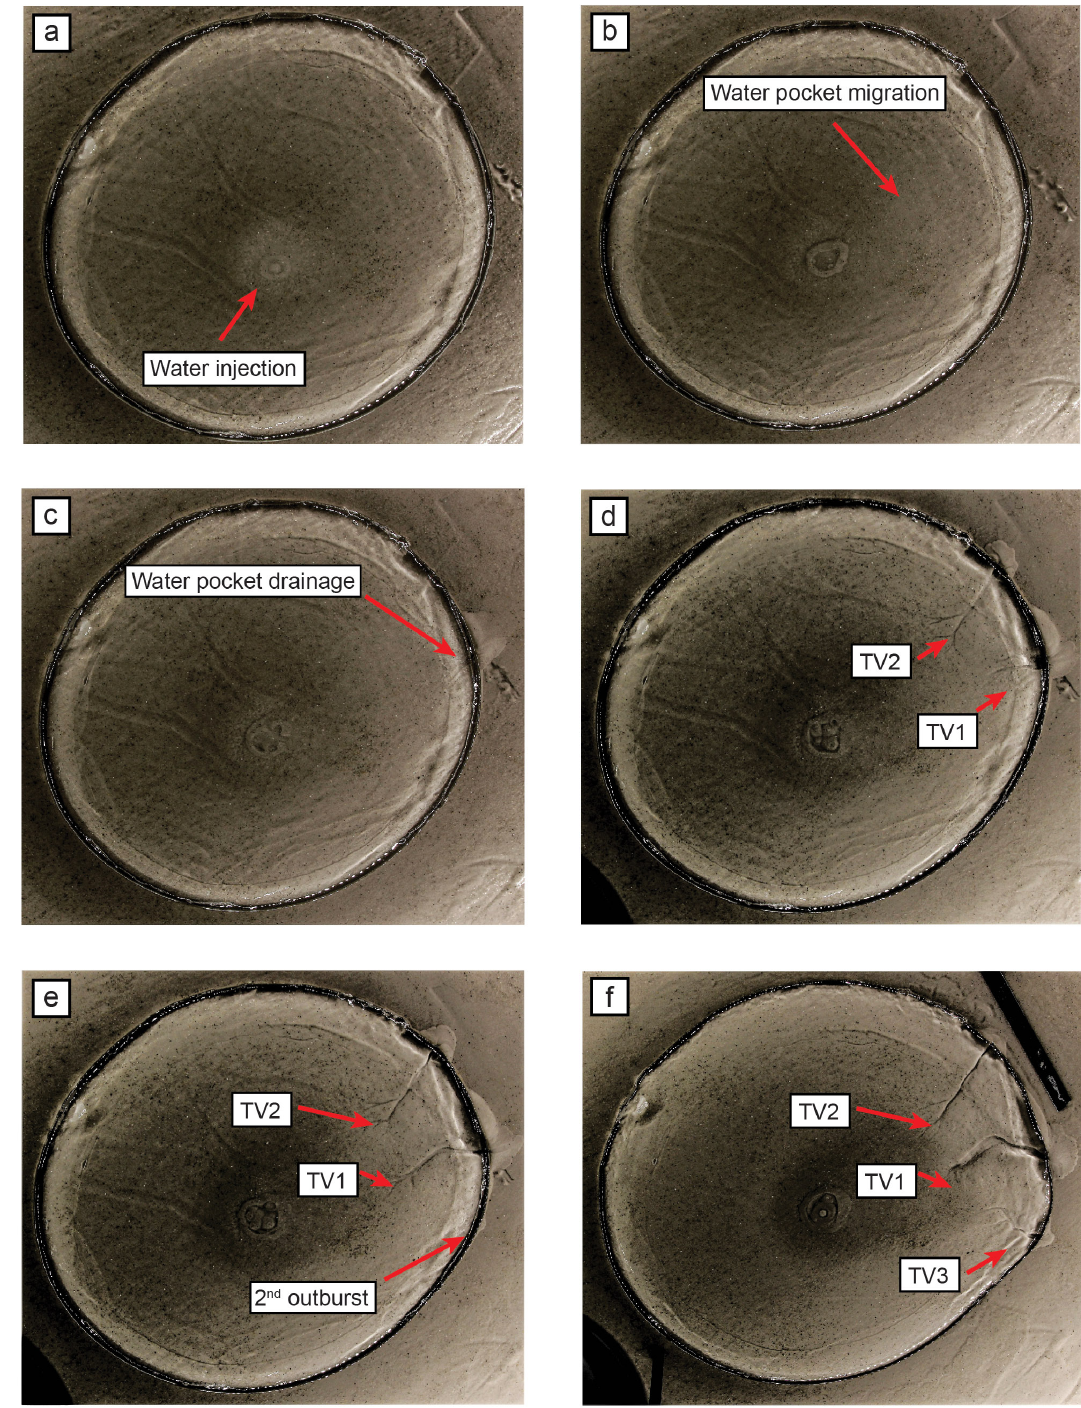
Figure 2. Temporal evolution of the experiment seen in raw photographs. (a) Formation of a water pocket. (b) Migration of the water pocket. (c) Marginal drainage of the water pocket and onset of the silicon stream. (d) Development of two tunnel valleys (TV1 and TV2). (e) Drainage of a second water pocket and silicon stream migration. (f) Development of a new generation of tunnel valleys (TV3) and silicon stream decay. Silicon flow velocity and silicon surface displacement maps corresponding to the six stages described here are presented in Fig. 3.